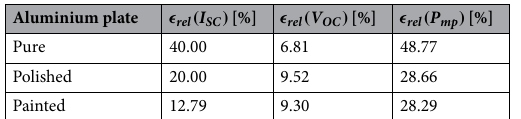
Table 6. Relative variation ( ǫ ) of characteristic values for the different aluminium